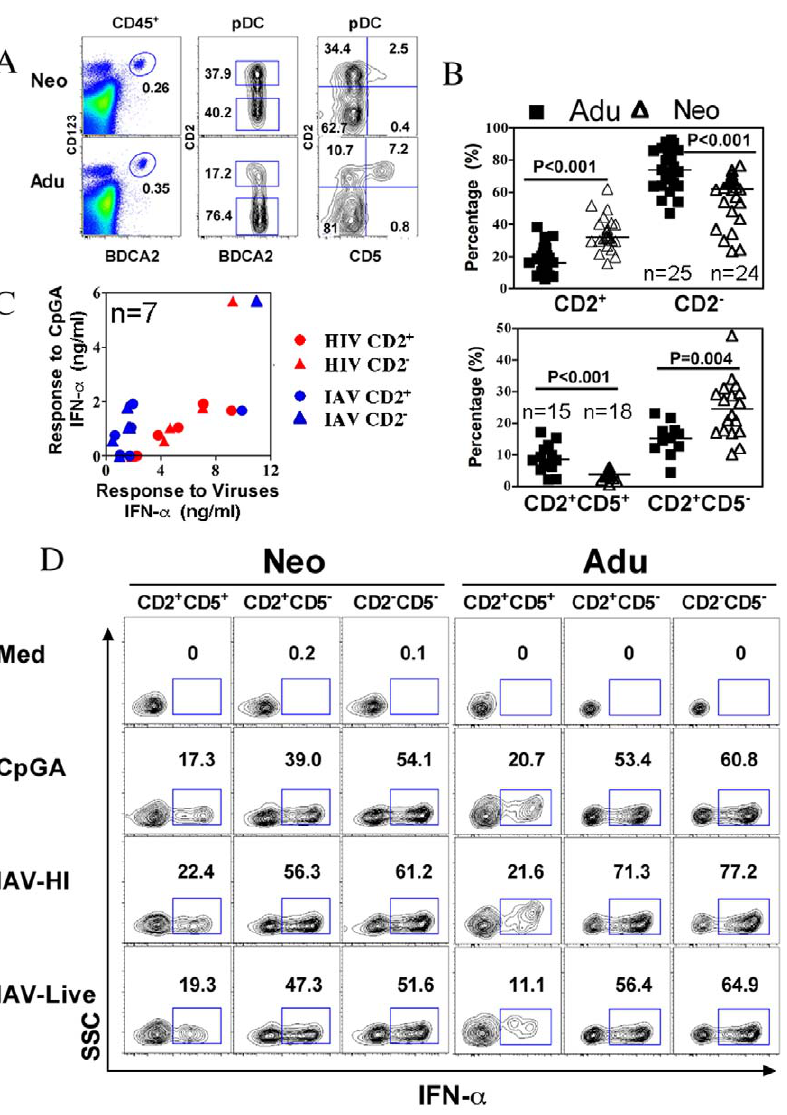
Figure 4. Heterogeneity of neonatal pDCs. (A) The percentages CD123 hi BDCA2 + pDCs within CD45 + MNC were calculated from neonatal cord blood and adults. pDCs could be subdivided by CD2 and CD5, and the accumulated data for CD2 + , CD2 - pDCs subsets and CD2 + CD5 + , CD2 + CD5 2 pDCs subsets are shown in (B). (C) The innate IFN- a production of sorted CD2 + and CD2 2 pDCs subsets to CpGA, live IAV and HIV (the results are incated as ng/ml). (D) Neonatal and Adult MNCs were stimulated as indicated and CD2 + CD5 + , CD2 + CD5 2 and CD2 2 CD5 2 pDCs subsets were gated to analyze their capacity to produce IFN- a detected by intracellular cytokine staining. Numbers indicate the percentage of cytokine-producing cells among gated cells. Data are representative of 5 experiments. The number of donors is indicated for each group (n) as well as P values for adults